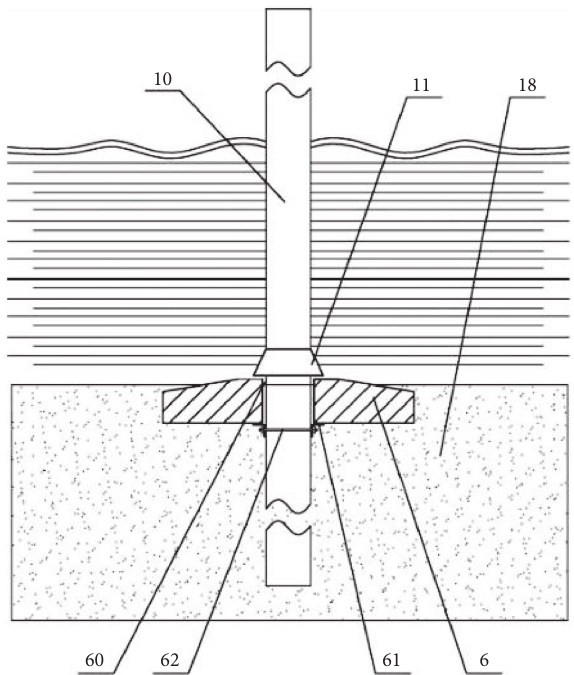
Figure 2: Radial variation of compaction effect of pile driving.